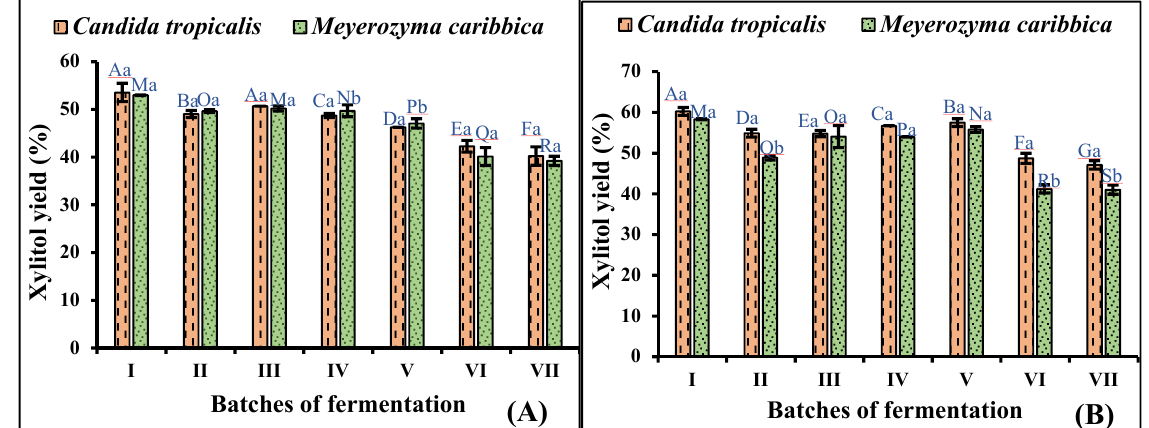
Figure 5. Repeated batch fermentation of adapted strains of C. tropicalis and M. caribbica in ( A ) non- detoxified rice straw hydrolysate, and ( B ) detoxified rice straw hydrolysate. Significant differences were calculated by two-way ANOVA using Bonferroni post-tests and are indicated by small and capital letters. In different batches, bars with different uppercase letters are significantly different, while bars with different lowercase letters represent significant differences in xylitol production by the two yeasts. Different letters denote significant difference between the two, and the same letter on the bar denotes no significant difference between the two at p <